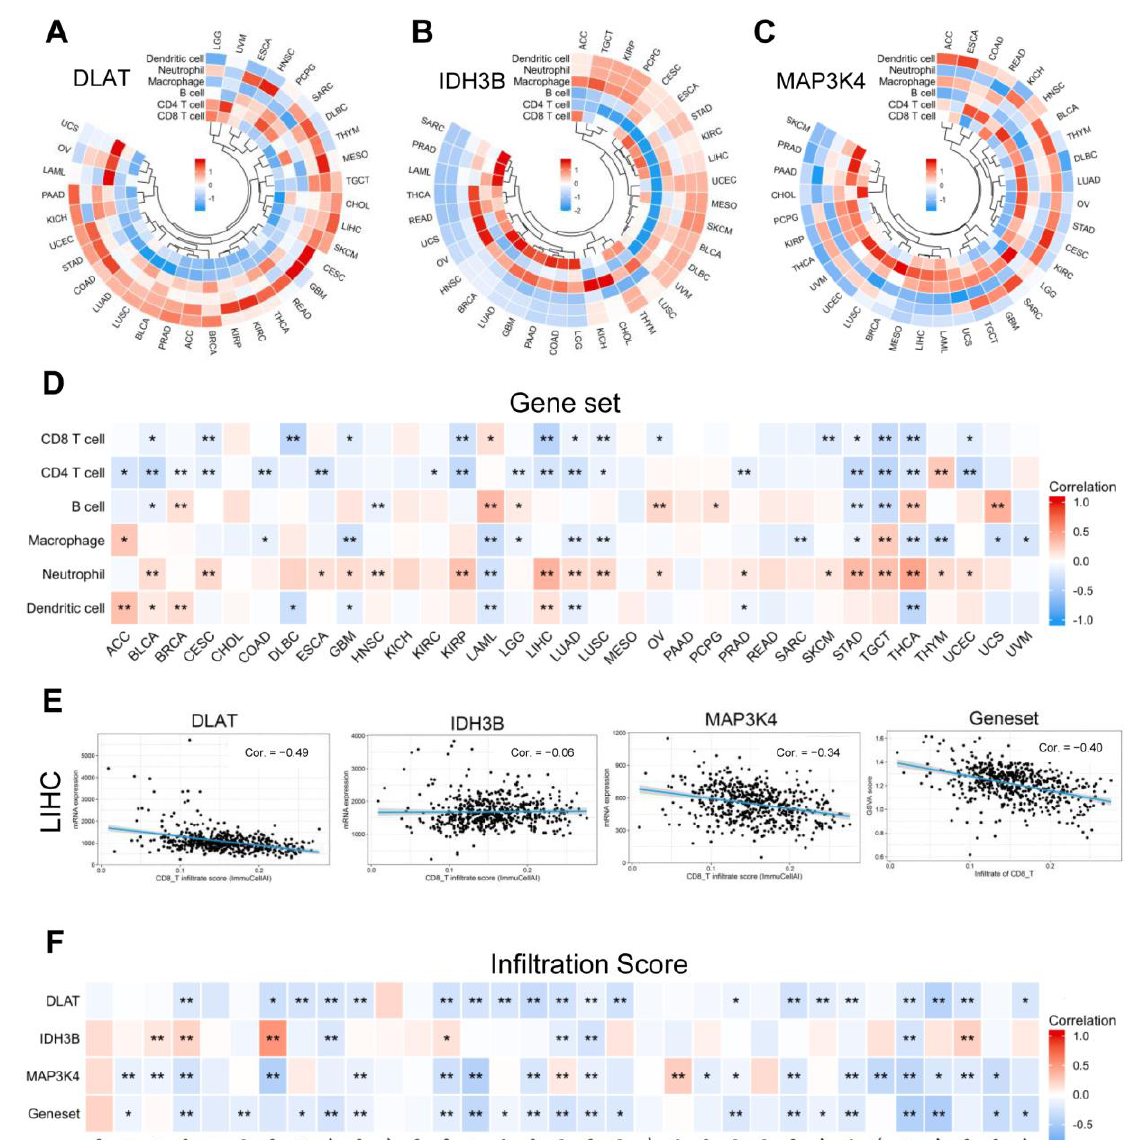
Figure 12. Correlation analysis of immune cell infiltration. ( A – C ) The correlation between the single gene expression levels and the infiltration of 6 immune cells. ( D ) The correlation between the gene set expression (based on GSVA score) and the infiltration of 6 immune cells. ( E ) Scatter plots showed that CD8 T cell infiltration was negatively correlated with the expression of DLAT, IDH3B, MAP3K4, and the gene set in TCGA-LIHC. ( F ) The correlation between gene expression levels and infiltration score in pan-cancer. * p < 0.05, ** p < 0.01.